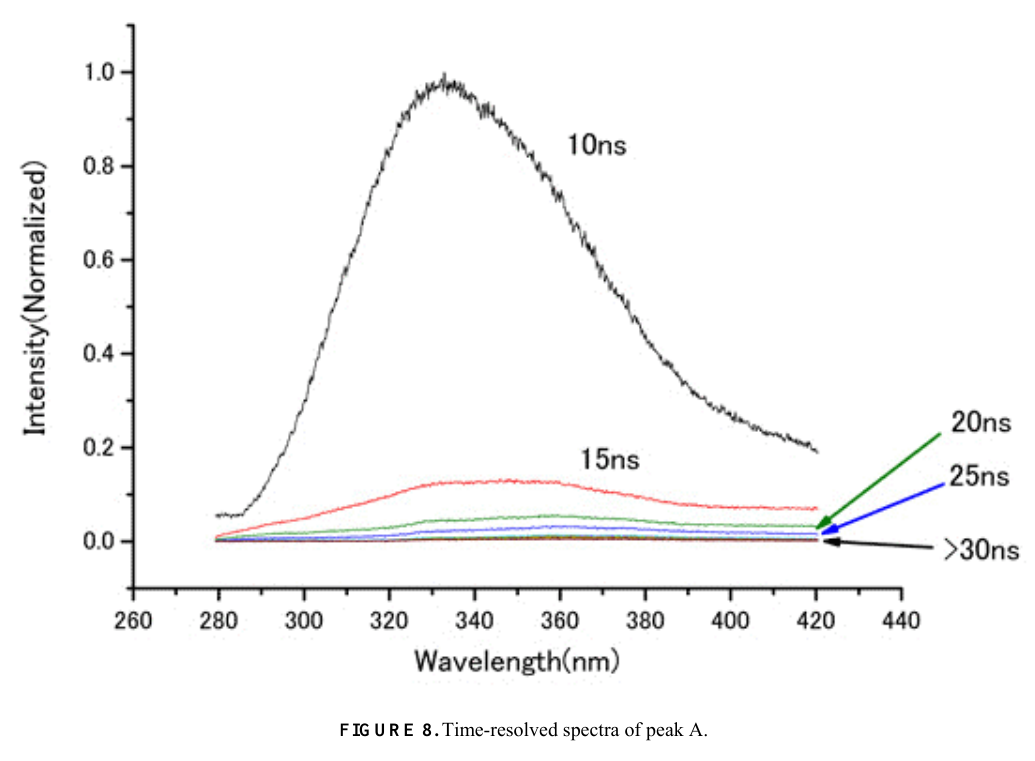
FIGURE 8. Time-resolved spectra of peak A.